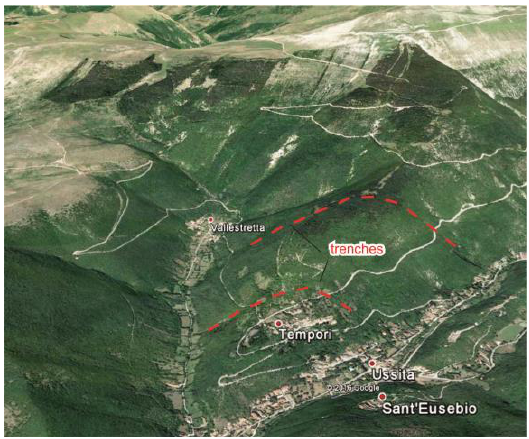
Figure 2 – The DSGSD of Ussita; data about the